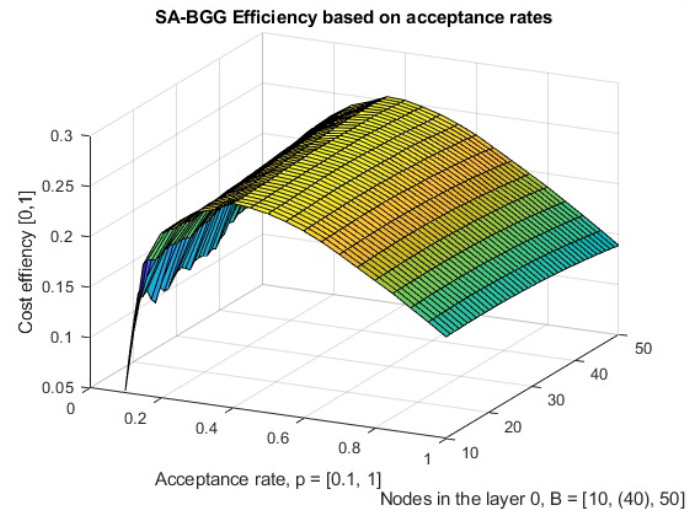
Figure 6. Acceptance rate optimization in layer